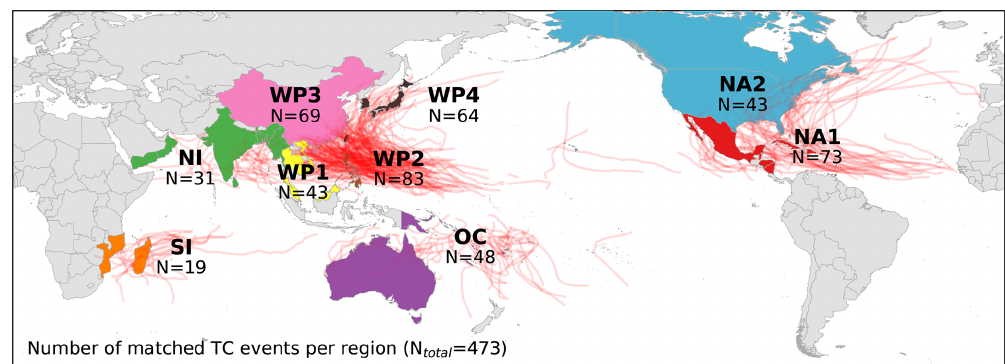
Figure 3. World map highlighting the 53 countries used for calibration, color coded per calibration region. The tracks of 376 TCs used for calibration are plotted as red lines. The number of resulting matched events N is displayed per region. Regions by color: red: the Caribbean with Central America and Mexico (NA1); blue: the USA and Canada (NA2); green: North Indian Ocean (NI); purple: Oceania with Australia (OC); orange: South Indian Ocean (SI); yellow: South East Asia (WP1), brown: the Philippines (WP2); rose: mainland China (WP3); black: the rest of the north West Pacific Ocean (WP4). The countries per region are listed in Table A1.